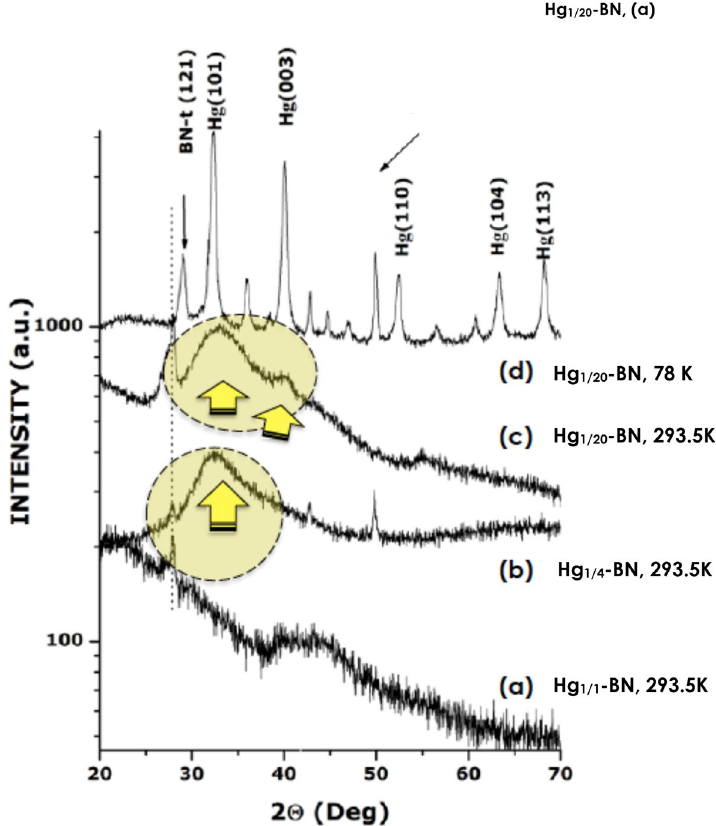
Figure 3. Room temperature X-rays diffraction profiles of the three different samples; ( a ) Hg 1/1 -BN, ( b ) Hg 1/4 -BN, ( c ) Hg 1/20 -BN and ( d ) nitrogen temperature diffraction pattern of this latter sample “Hg 1/20 -BN nano- composite at ~ 78